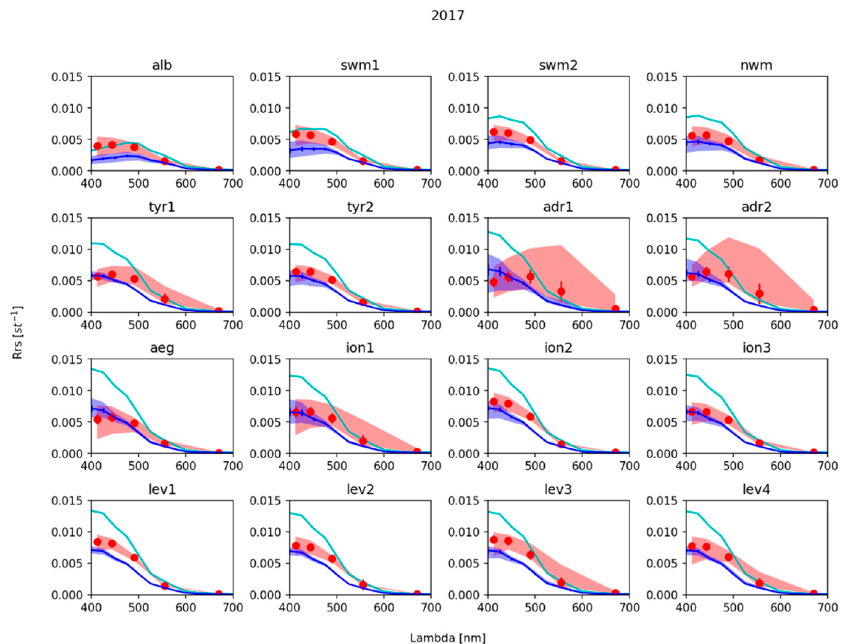
Figure 6. Remote sensing reflectance (unit st − 1 ): red dots are the CMEMS satellite products [41], blue lines model results for experiment EXP-3. The blue lines with the error bar are the modelled remote sensing reflectance computed above the sea surface (Rrs(0+)) with the correction [36], and the other cyan lines are the modelled remote sensing reflectance computed below the sea surface (Rrs(0-)). Vertical bars show standard deviation. Shaded areas for satellite and model are the interval between the 5th and 95th percentile. Data and model are averaged over the year 2017. Each panel shows the spatial averages over the CMEMS sub-basins reported in Figure 4.